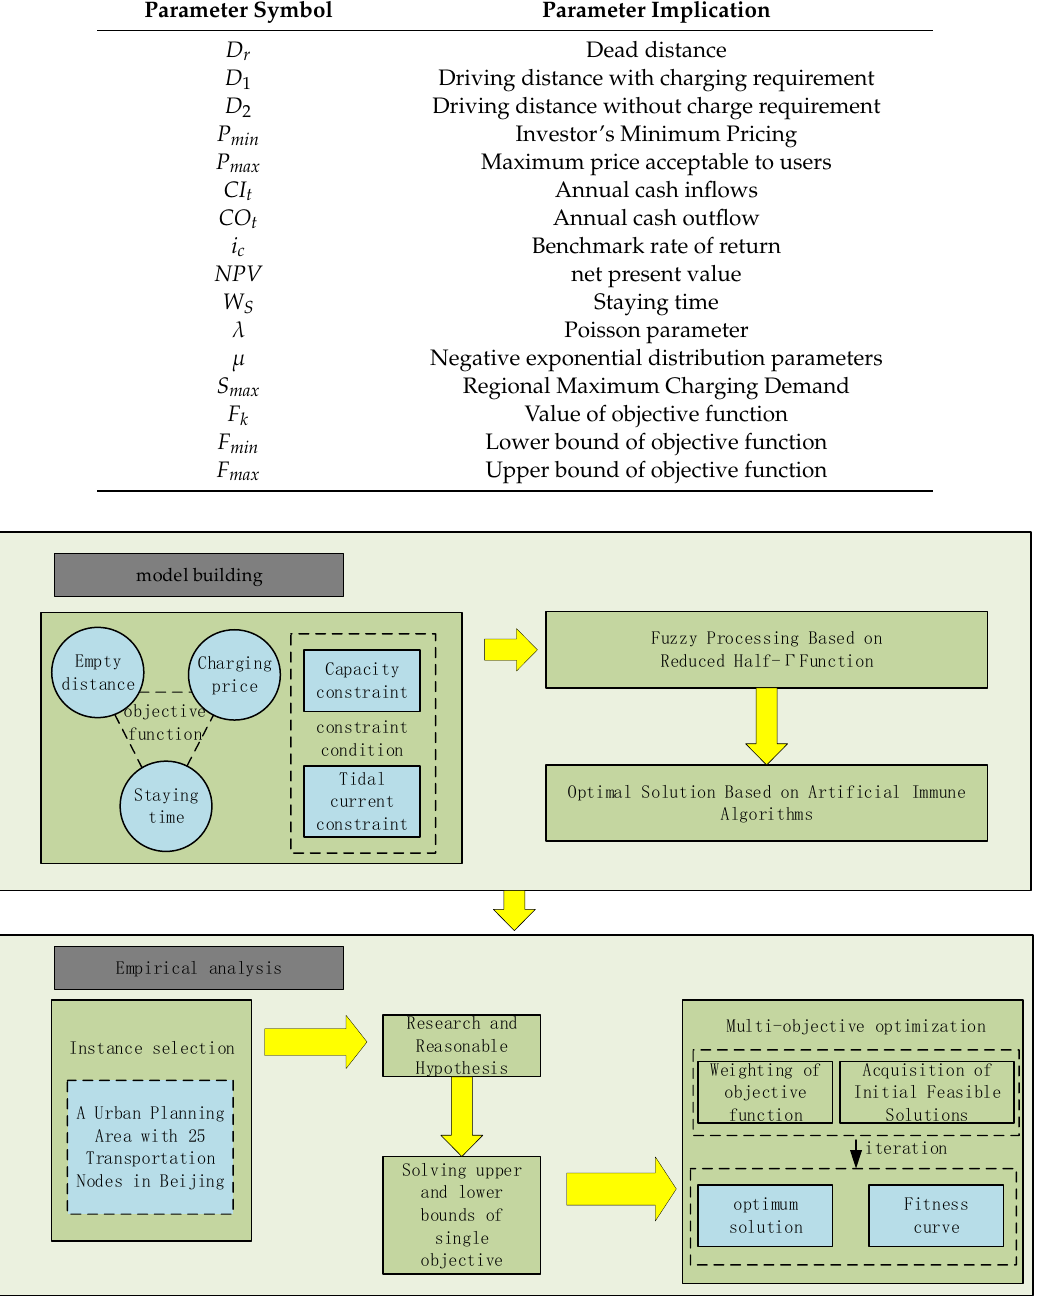
Figure 2. Research technology roadmap. The possible parameters and symbols in the text, formulas and diagrams of this paper are shown in Table 1. Table 1. Symbols and Implications of Parameters.